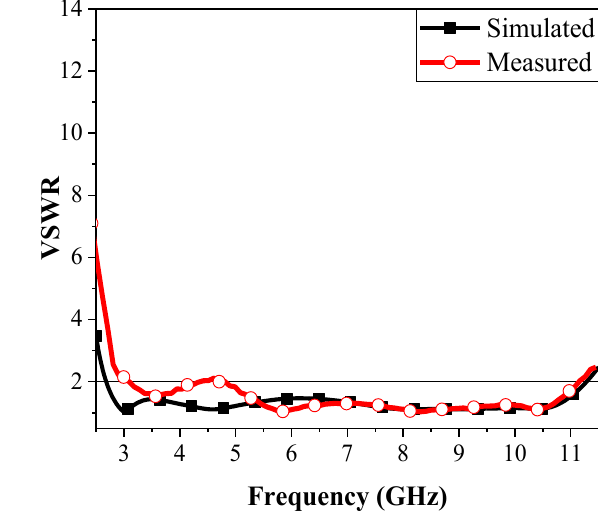
FIGURE 8. Fabricated prototype of the proposed U-shaped CPW-fed UWB antenna, (a) front view, (b) back view.